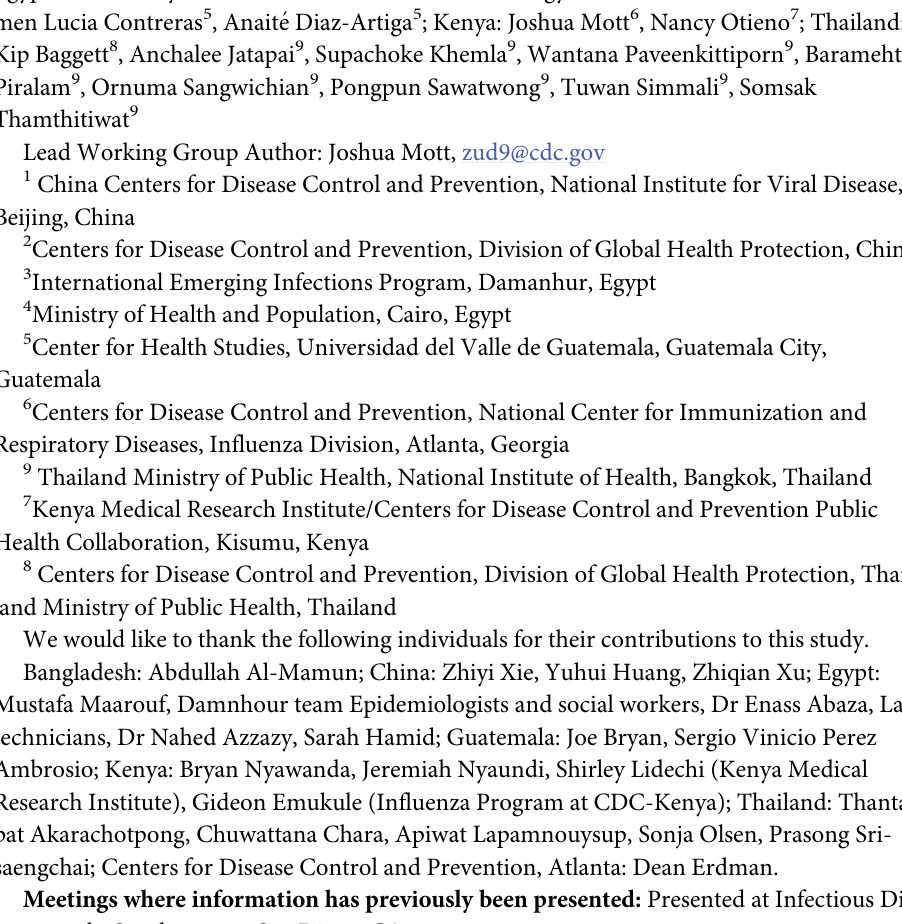
S4 Table. Percentage of severe acute respiratory infection (SARI) patients and asymptom- atic adults in which pathogens were